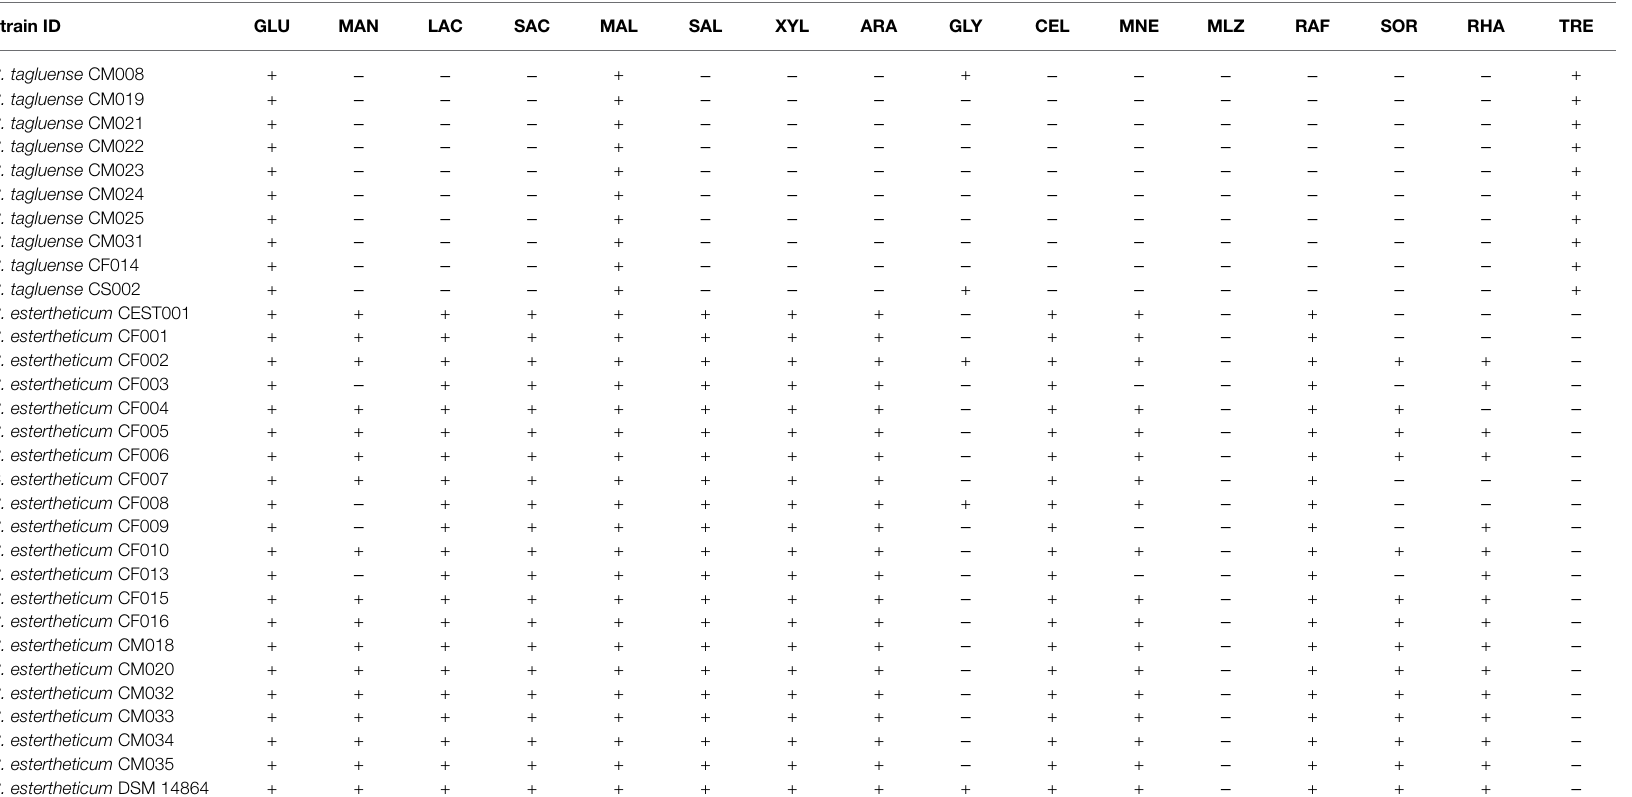
TABLE 2 | Substrate utilization by in-house C. estertheticum and Clostridium tagluense (+, positive reaction and − , negative reaction). Strain